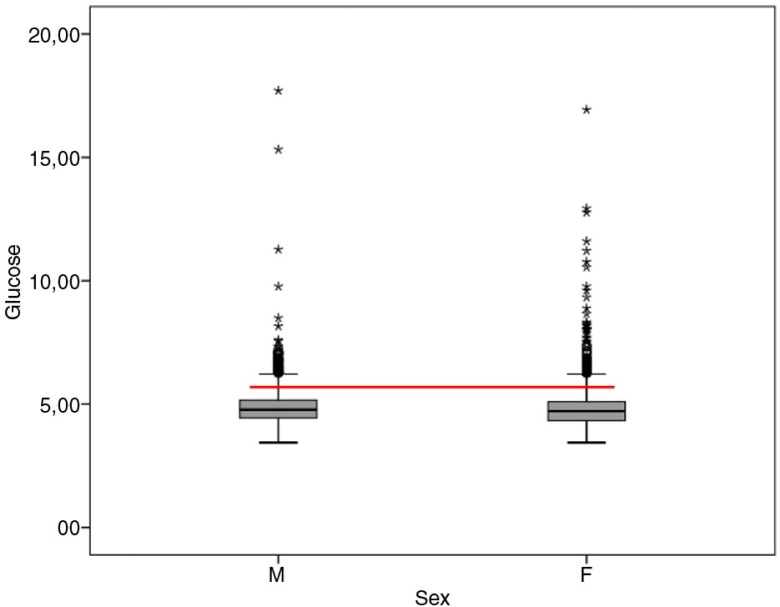
Levels of fasting glucose. Glucose in mmol/L. The horizontal line separates the students with euglycemia ≤5.5 mmol/L (under) from those with hyperglycemia values ≥5.6 mmol/L (up). Chi-square test results for gender and fasting glucose had a value of 1.783 with p=0.410, which shows that there was no association between gender and glucose.